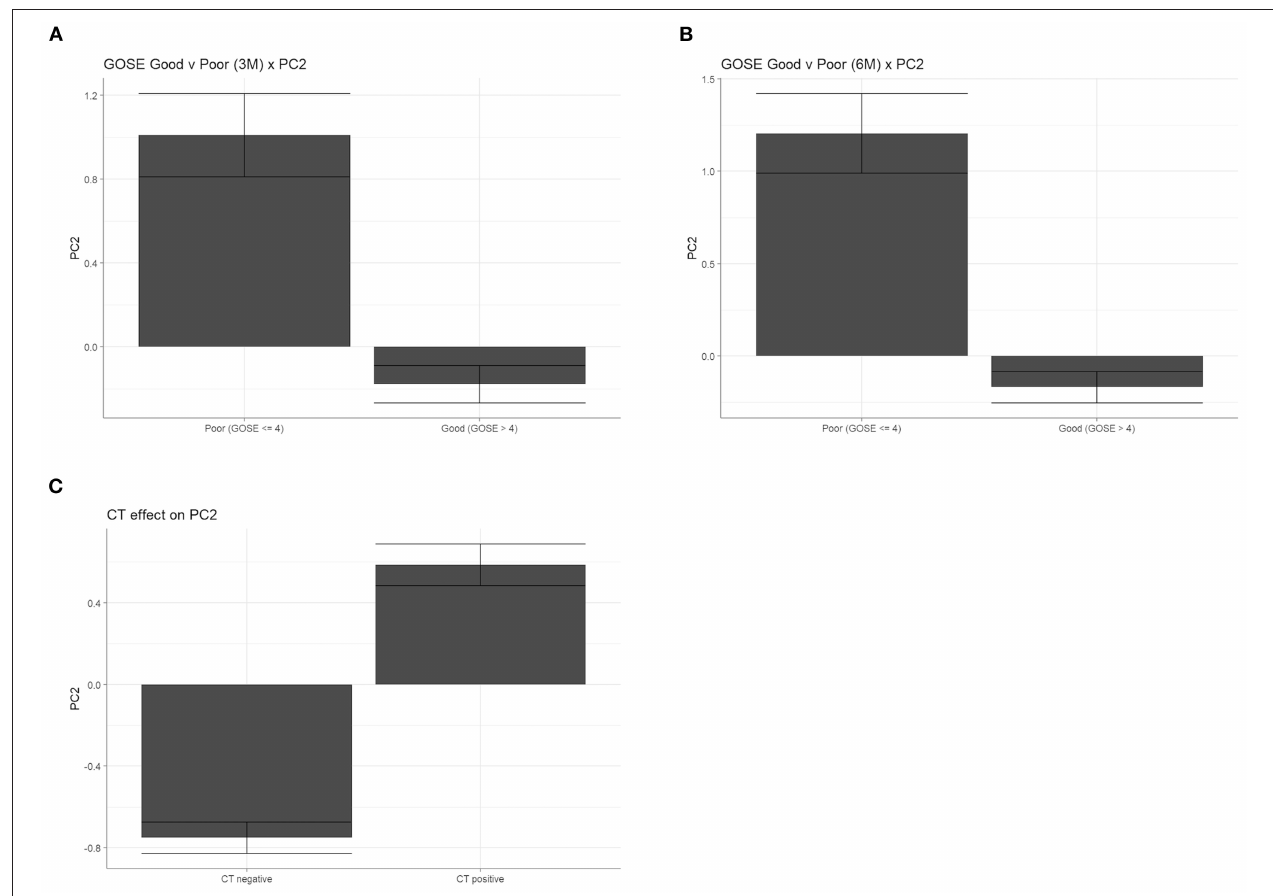
FIGURE 5 | The inflammatory biomarker profile is associated with poor outcome and CT pathology. Individual PC scores for each patient that were generated from the inflammatory second PC, in which higher values are indicative of higher pro-inflammatory expression. Inflammatory PC scores were significantly higher in patients with poor recovery (GOS-E ≤ 4) vs. good (GOS-E > 4) recovery, at both 3 months ( A , Welch’s t = − 5.43, p < 0.01) and 6 months ( B , Welch’s t = − 5.46, p < 0.01). (C) Patients with positive diagnosis on CT pathology had significantly higher PC2 inflammatory scores (Welch’s t = 10.53, p <